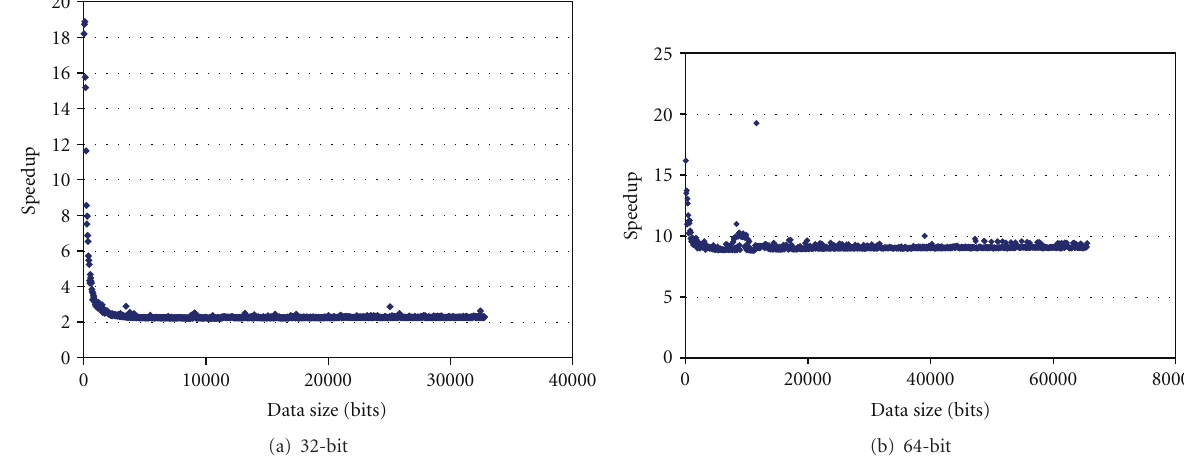
Figure 14: Multiplication hardware speedup versus portable GMP.